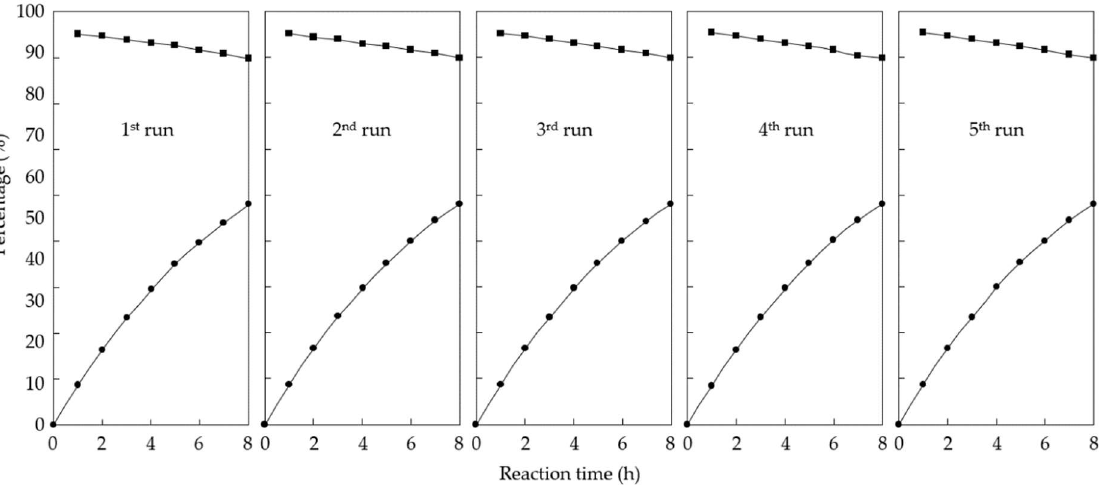
Figure 4. Time courses of solid catalyst Pd-PW-HAP in the propylene epoxidation by O 2 in methanol for 5 runs. (●): Propylene conversion; ( ■ ): selectivity for PO. Reaction conditions: same as those in